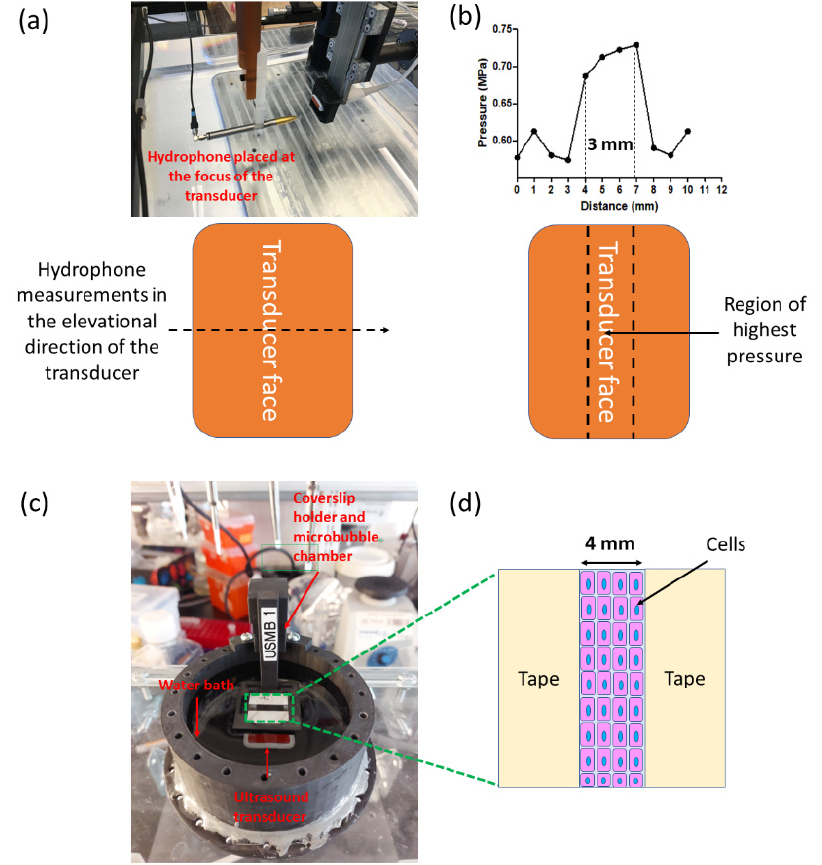
Figure 3. Characterization of ultrasound transducer using hydrophone. ( a ) Image of the hydrophone setup used for measuring ultrasound pressure. The hydrophone was placed at a focal distance of 3 cm from the face of the transducer. Hydrophone position was changed in steps of 1 mm to measure the pressure along the elevational direction of the transducer, as indicated by the dotted arrow. ( b ) Ultrasound pressure at the focal plane of the transducer measured using the hydrophone setup. The pressure was highest within a 3 mm wide region at the centre of the transducer. ( c ) Image of UMCC platform with taped coverslip. Cells were cultured within the un-taped, 4 mm wide region, so that all the cells were exposed to highest ultrasound pressure. ( d ) Schematic of the taped coverslip showing cells cultured in the 4 mm wide region.